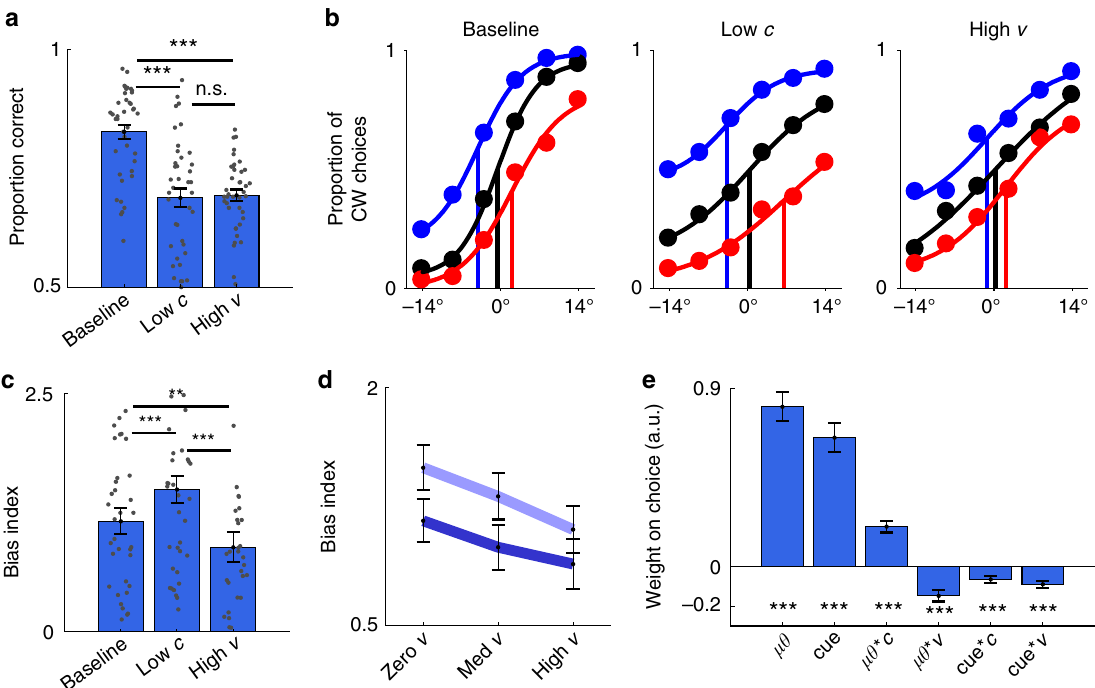
Fig. 2 Effects of contrast and variability on choice behaviour. a Choice accuracy for the baseline, reduced contrast (low- c ) and increased variability (high- v ) conditions. b Psychometric curves are shallower in the low- c and high- v conditions compared to baseline. The x -axis indicates average orientation relative to horizontal (negative: CCW; positive: CW). Choices shift towards the cued category on biased trials (blue: 75% CW; red: 25% CW) compared to neutral trials (black), but less so in the high- v condition. Vertical lines mark the in fl ection points of psychometric functions fi tted to the average data. Psychometric curves were created for illustration. c Bias index, a measure of cue usage, is higher in the low- c condition, but lower in the high- v condition, compared to baseline. d Factorial analysis of the effects of contrast and variability on the bias index shows a decrease with contrast (dark blue: high contrast; pale blue: low contrast) and a decrease with variability. e Trial-by-trial in fl uence of prior cue on choices measured using logistic regression. μθ : signed mean orientation; cue: signed prior cue; c : contrast; v : variability. a – e Data are represented as group mean ± SEM. * p < 0.05, ** p < 0.01, * ** p < 0.001. For panel a , only neutral trials were used. For panels b and e , both neutral and biased trials were used. For panels c and d , only biased trials were